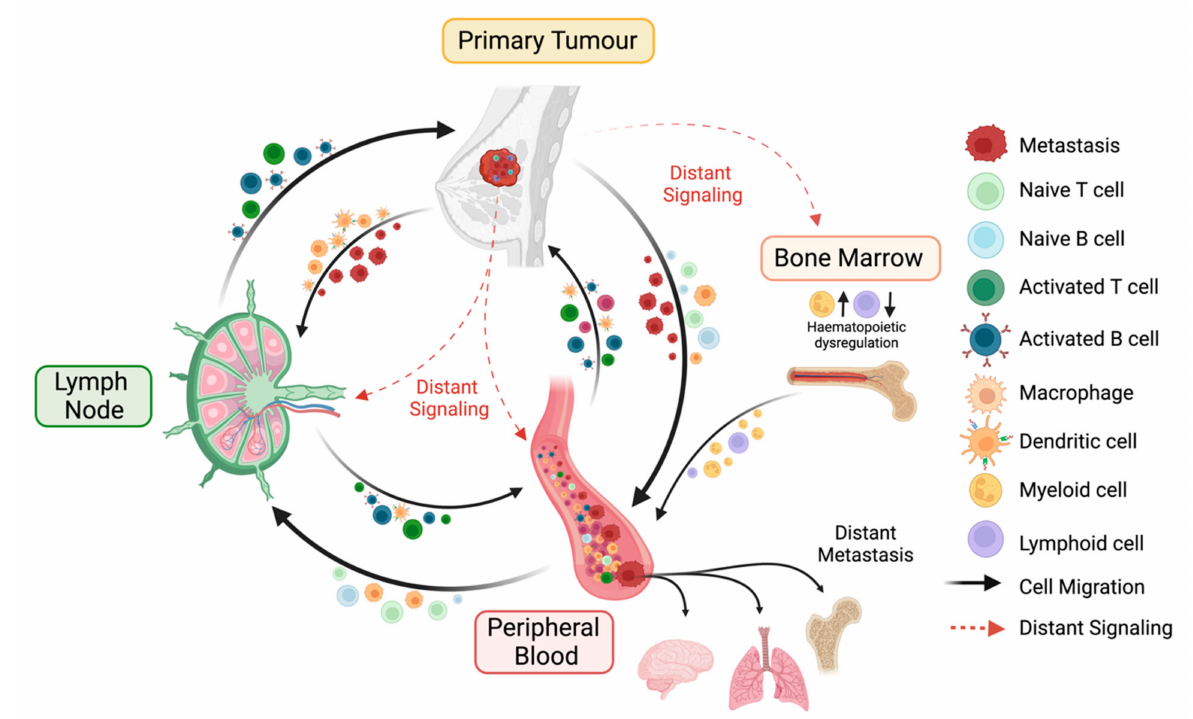
Figure 1. Key interactions of the immune macroenvironment. The cancer-immunity cycle is a coordi- nated process involving the primary tumour, the peripheral blood, and the tumour-draining lymph node (LN), with the potential to generate effective anti-tumour immune responses. The primary tumour can either interact directly with the peripheral blood and the LN due to the dissemination of cancer cells or indirectly via the secretion of distant immunosuppressive mediators. The presence of a tumour induces hematopoietic dysregulation via increased abundances of hematopoietic stem cells (HSCs) and granulocyte monocyte progenitors (GMPs) in the bone marrow, followed by peripheral blood alterations where myeloid and lymphoid cells are increased and decreased, respectively. Tu- mour antigens secreted from the primary tumour can travel to the two other sites. Antigen presenting cells (APCs), e.g., macrophages and dendritic cells (DCs), which have encountered these antigens, either at the tumour lesion or in the periphery, are trafficked to the LN, where they prime and activate naïve lymphocytes. These primed effector immune cells then infiltrate the tumour to carry out effector functions or enter the circulation as memory